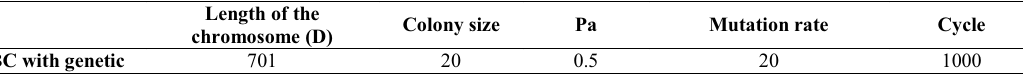
Table 5. Hybrid algorithm